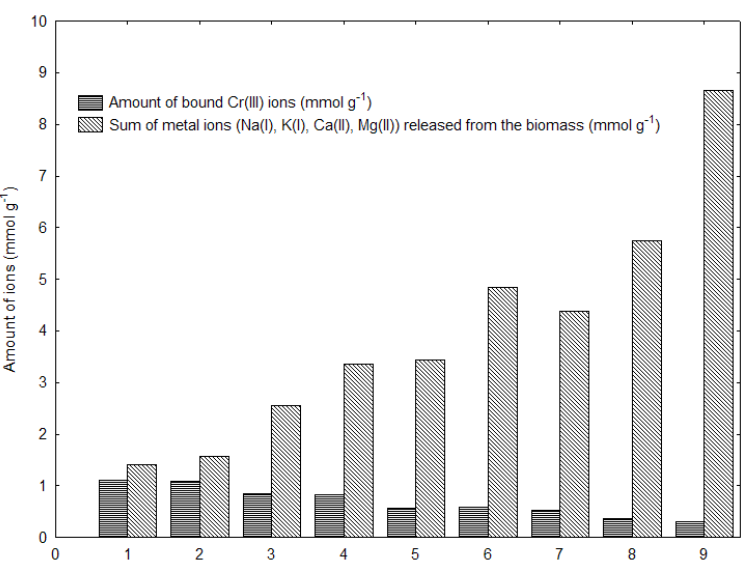
Figure 5. The effect of increase in concentration of light metal ions in the solution on biosorption capacity of Enteromorpha prolifera towards Cr(III) ions (25°C, pH 5, C 1.0 g L -1 , C Cr(III) 300 mg L -1 S 0